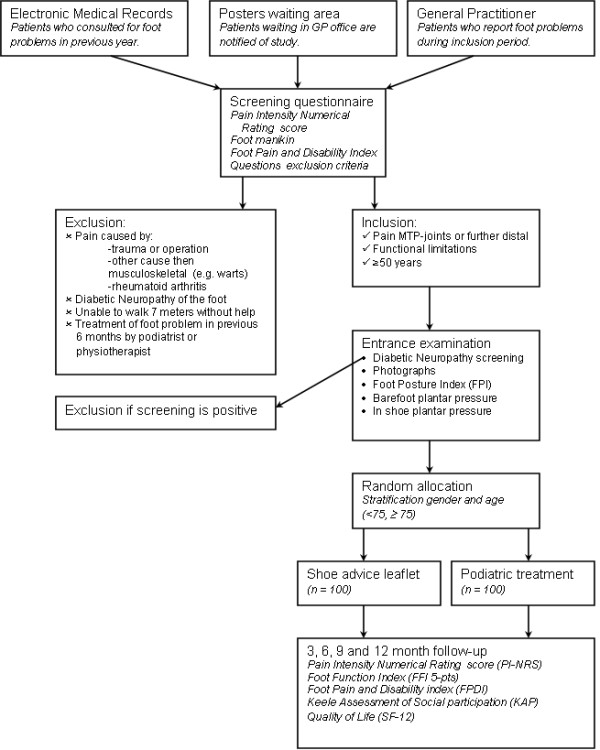
Design of the RCT